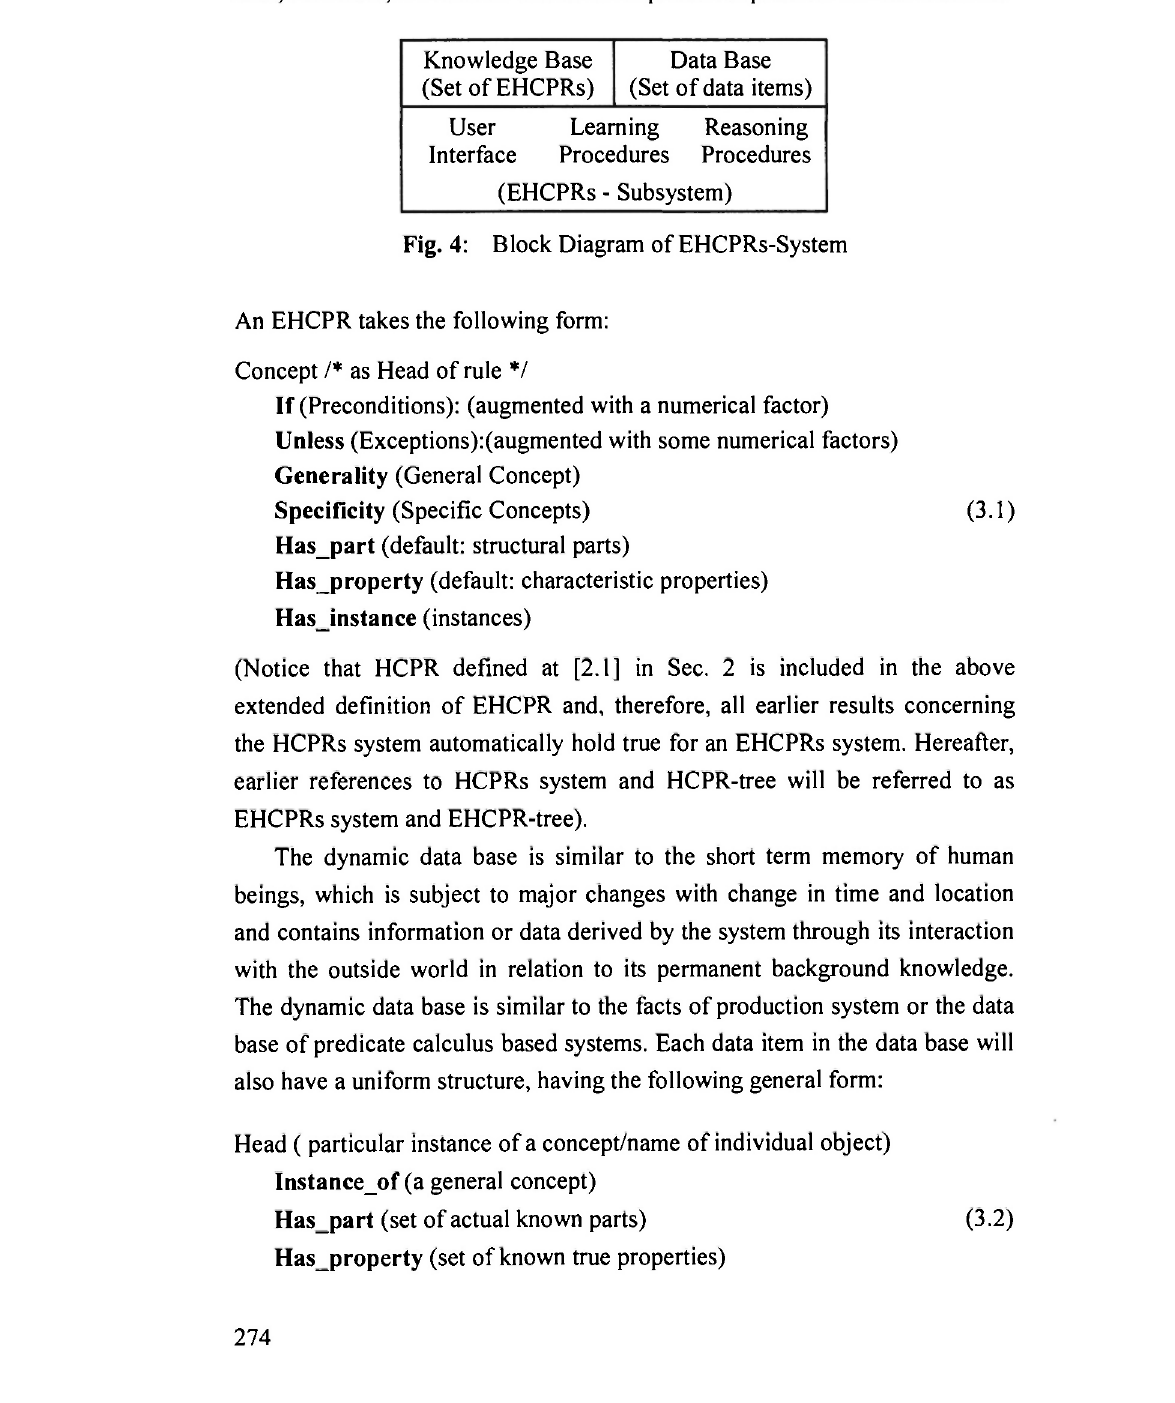
Fig. 4: Block Diagram of